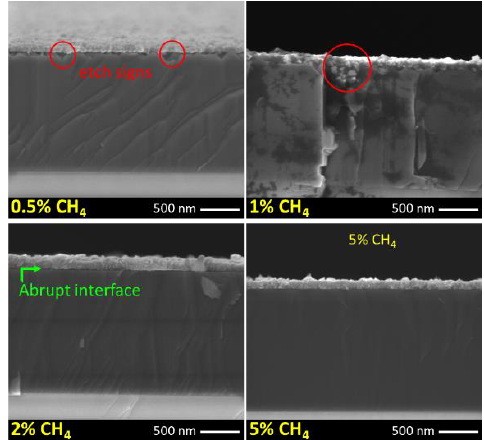
Figure 2. CH 4 content e ff ect on the interface of the diamond / Si 3 N 4 / GaN (cross-sectional SEMs).